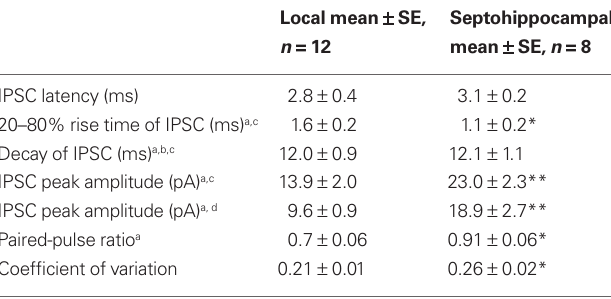
Table 2 | Summary of iPSC properties at local and septohippocampal inhibitory inputs to O–LM